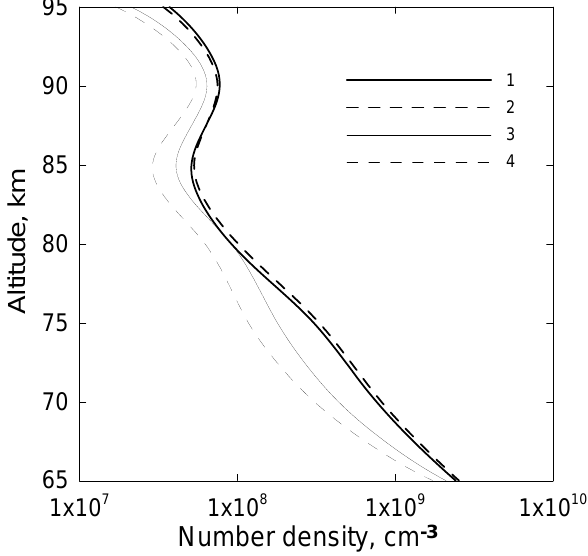
Fig. 10. Altitude profiles of ozone concentration retrieved from si- multaneous observations of O 2 emissions at 762nm and 1.27 µ m in METEORS (Mlynczak et al., 2001). Retrievals in accordance with: our model – solid lines, model of Mlynczak et al. (1993) – dashed lines. Curves 1 and 2 – retrievals from measurement of emission at 762nm O 2 (b 1 6 + g , v=0 → X 3 6 − g , v=0). Curves 3 and 4 – retrievals from measurement of emission at 1.27 µ m O 2 (a 1 1 g , v=0 → X 3 6 − g , v=0).